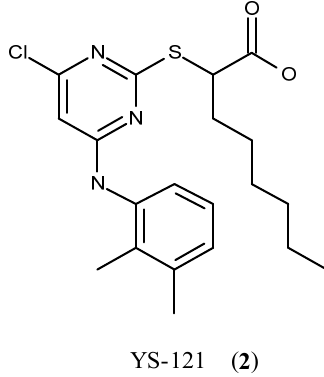
Figure 2. Chemical structure of